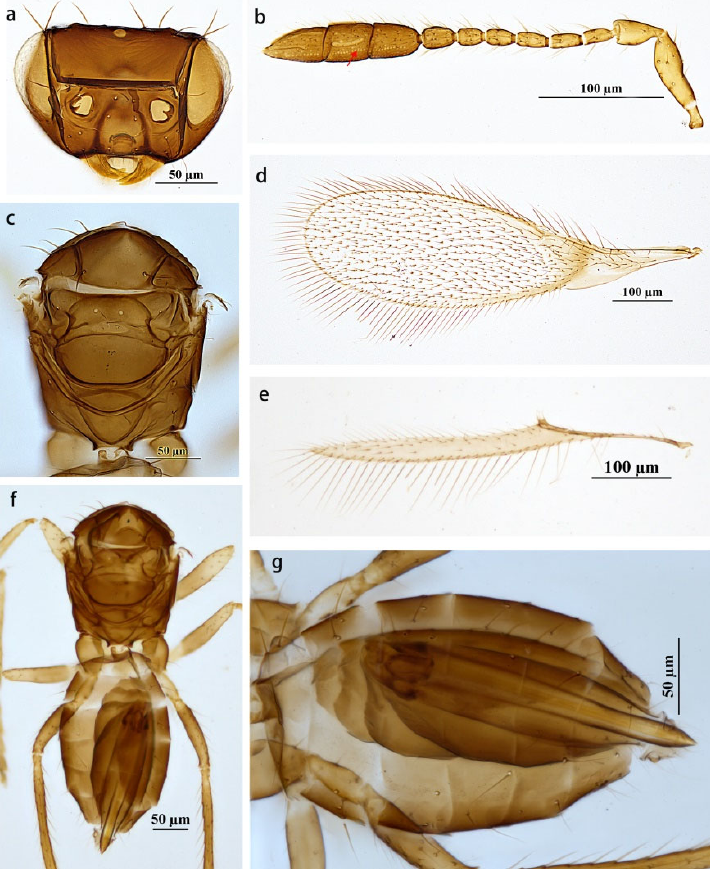
Figure 3. Pseudanaphes zhaoi . Female. ( a ) Head; ( b ) antenna; ( c ) mesosoma in dorsal view; ( d ) fore wing; ( e ) hind wing; ( f ) body in dorsal view; ( g ) metasoma in dorsal view. Mesosoma (Figure 2c,f) smooth and about 0.69 × length of metasoma. Lateral plate of pronotum with six setae on each, midlobe of mesoscutum with two setae, each side lobe with one, and each axilla with one seta; scutellum without setae; propodeum with a pair of setae on both sides. Fore wing (Figure 2d) about 3.81 × as long as wide, disc with a slight brownish tinge and a curved, infuscate band below proximal half of marginal vein, and infuscate below submarginal vein; densely setose, with setae extending nearly to the wing base; longest marginal seta 0.49 × (0.48–0.52 × ) greatest width of wing. Hind wing (Figure 1e) 21 × as long as wide; longest marginal seta 2 × greatest width of wing. second metasomal tergite and occupying about 0.99 × length of metasoma, exserted be- as